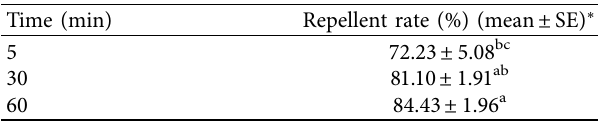
Table 1: Repellent rate of Plectranthus tomentosa fresh juice on Tetranychus kanzawai